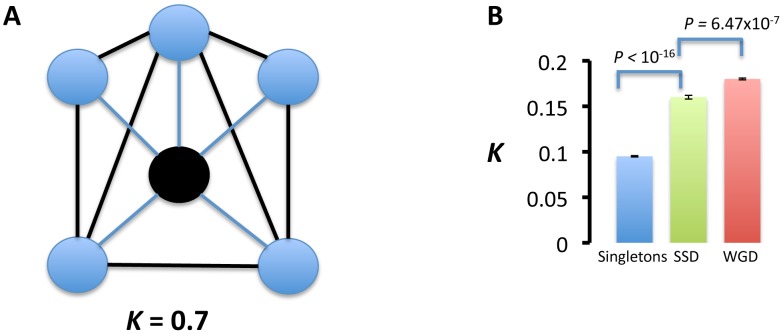
Interaction partners of duplicated genes are more functionally related than those of singletons.(A) We calculated the functional relatedness of the interaction partners (blue circles) of a gene as the proportion of links (l) between these partners (black thick lines) taking into account the number of partners (n): k = 2l/n(n−1). For example, in (A), there are 7 links between the 5 partners of a gene (black circle), which yields k = 2×7/5×4 = 0.7. (B) Clustering coefficients for singletons, small-scale duplications (SSDs) and whole-genome duplications (WGDs). The columns represent the mean clustering coefficient and the standard error of the mean associated to that particular set of genes. Probabilities were calculated by the Wilcoxon rank test. Duplicates interact with genes more functionally related than those with which singletons interact. SSDs interact with genes that are more functionally dispersed (unrelated) than the interaction partners of WGDs.